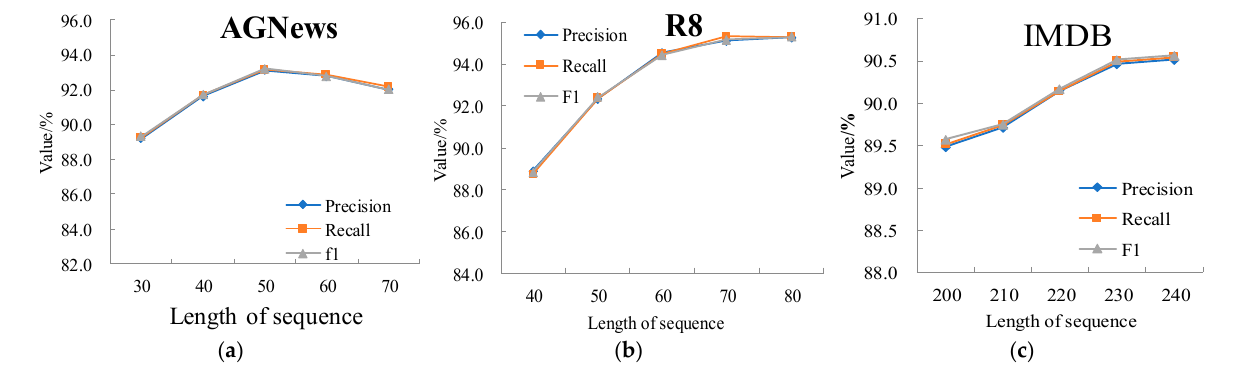
Figure 6. Classification performance of different sequence lengths in three datasets. ( a ) represents the influence of different text sequence lengths on model classification in AGNews data set; ( b ) represents the influence of different text sequence lengths on model classification in R8 data set; ( c ) represents the influence of different text sequence lengths on model classification in IMDB data set.